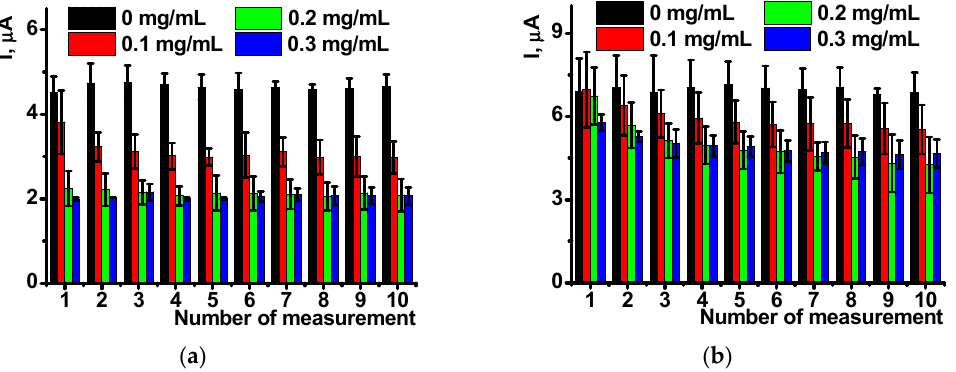
Figure 4. The reproducibility of the oxidation ( a ) and reduction ( b ) peak currents recorded on glassy carbon electrode modified with poly-NR layer obtained in the presence of various amounts of DNA. Scan rate 50 mV/s. Results are mean ± SD from 5 repetitions.